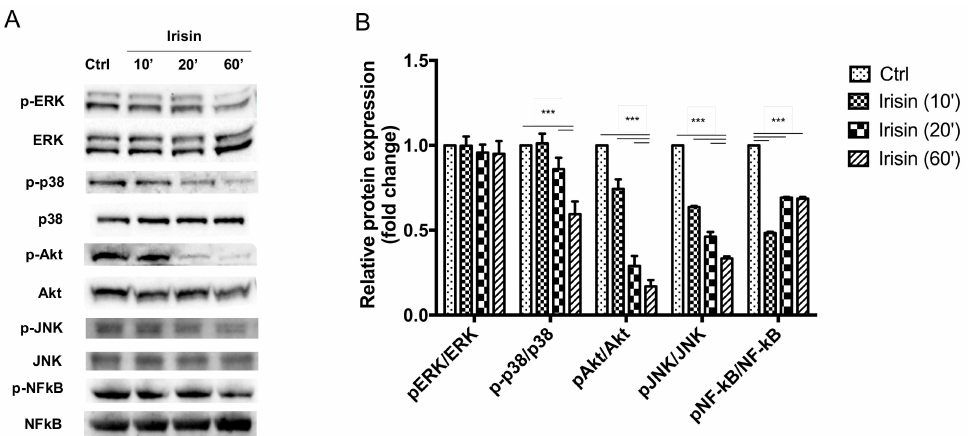
Figure 4. Irisin inactivates p38 mitogen-activated protein kinase (p38 MAPK), protein kinase B (Akt), c-Jun N-terminal kinase (JNK), and nuclear factor kappa-light-chain-enhancer of activated B cells (NF κ B) pathways within hOAC. ( A ) Western blot analysis showed a reduction in p-p38, p-ERK, p-Akt, p-JNK and p-NF κ B levels after irisin exposure at 10, 20, and 60 min. n = 5. ( B ) Densitometric analysis of protein bands demonstrated a significant decrease of p-p38 levels at 20 and 60 min. Similarly, p-Akt, p-JNK, and p-NF κ B levels were significantly decreased at each time point. The p-ERK levels were not significantly decremented at each time point. n = 5. *** p <